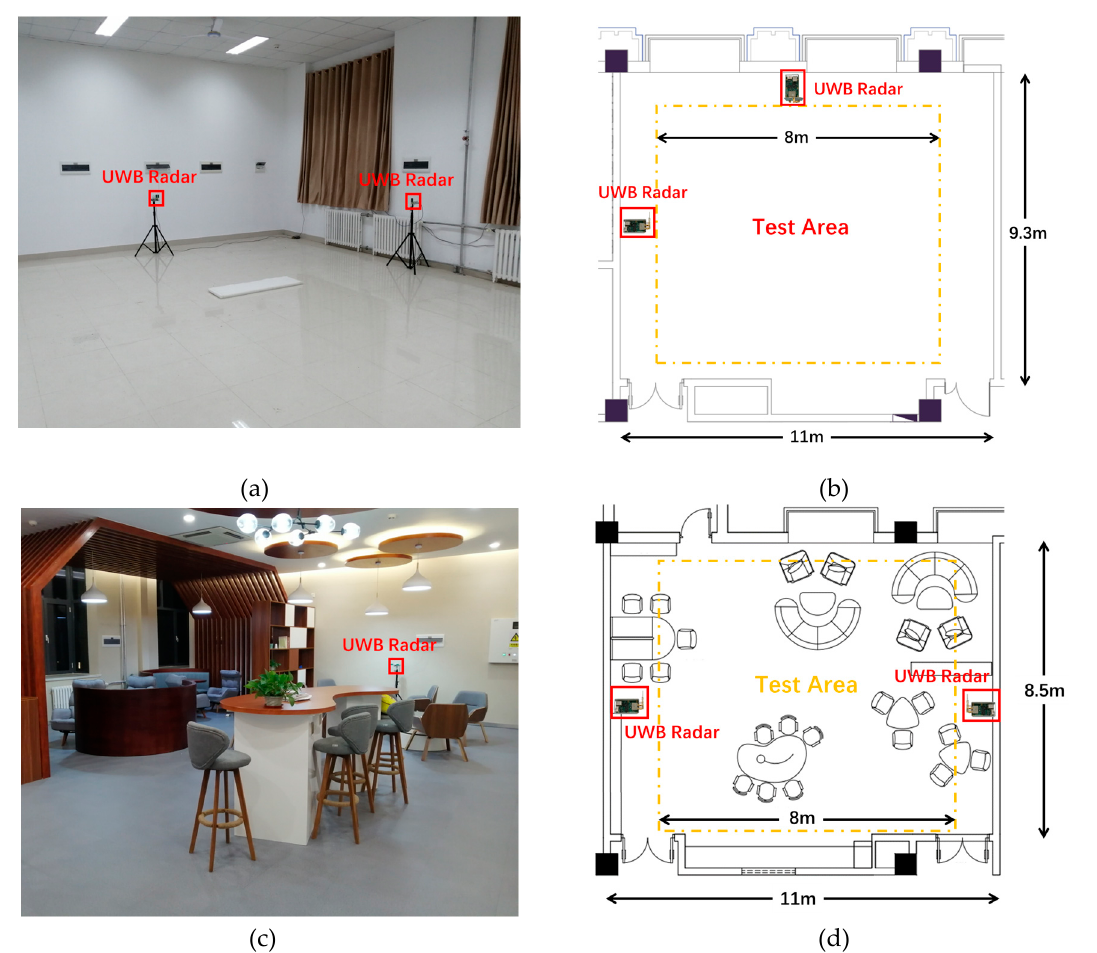
Figure 2. ( a ) A photo of the laboratory environment. ( b ) Floor plan of the laboratory environment. ( c ) A photo of the lounge environment. ( d ) Floor plan of the lounge environment. Sensors 2020 , 20 , x FOR PEER REVIEW